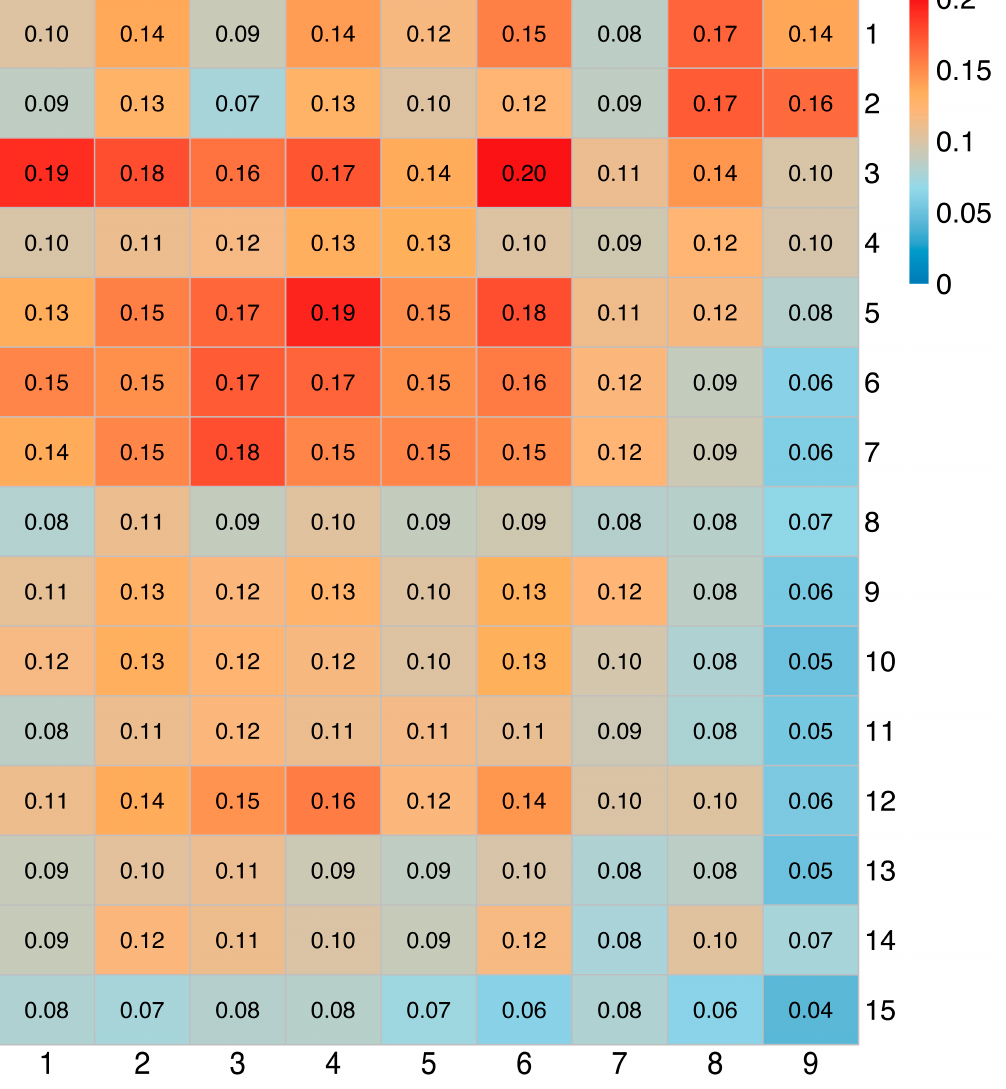
Figure 5. The heat map of similarity of cell clusters between the adult group and the child group. The X-axis is the cell cluster of the child group, and the Y-axis is the cell cluster of the adult group. The values and colors in the figure represent the value of the Jaccard coefficient, namely, the Jaccard